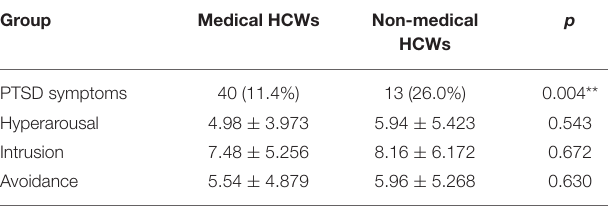
TABLE 3 | Comparisons of the IES-R scores between medical and non-medical HCWs. Group